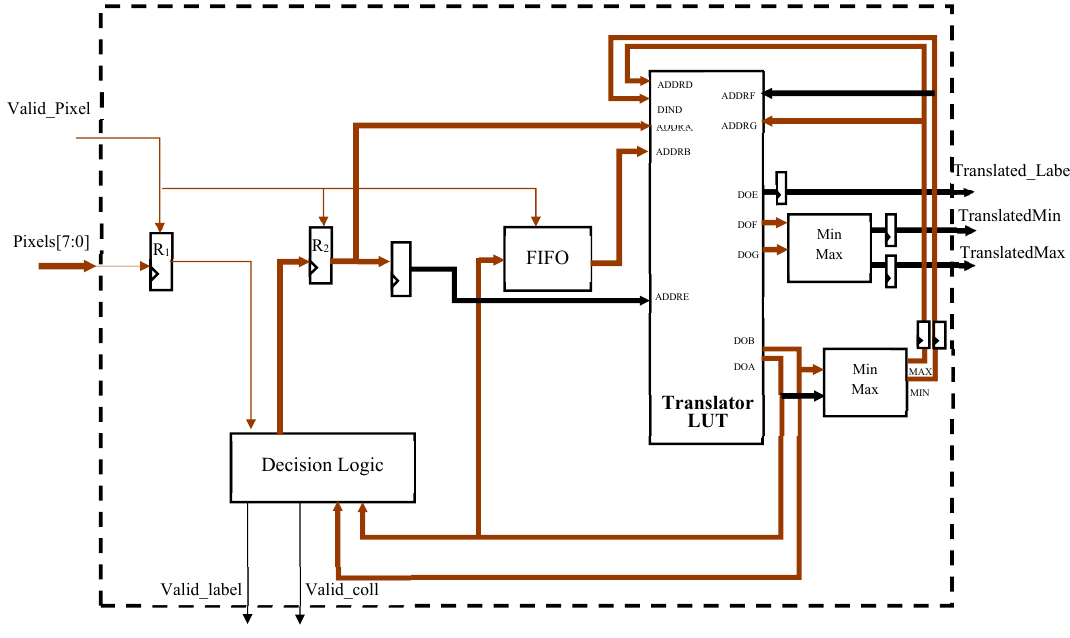
Figure 10. Design of the Decision module.